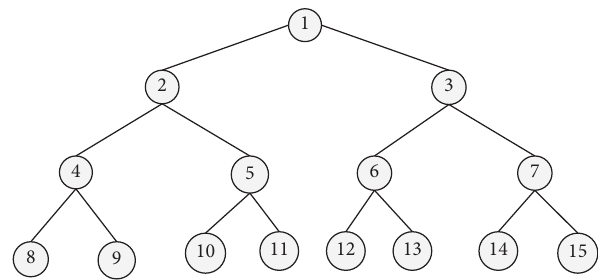
Figure 5: The perfect binary tree with label ID of Figure